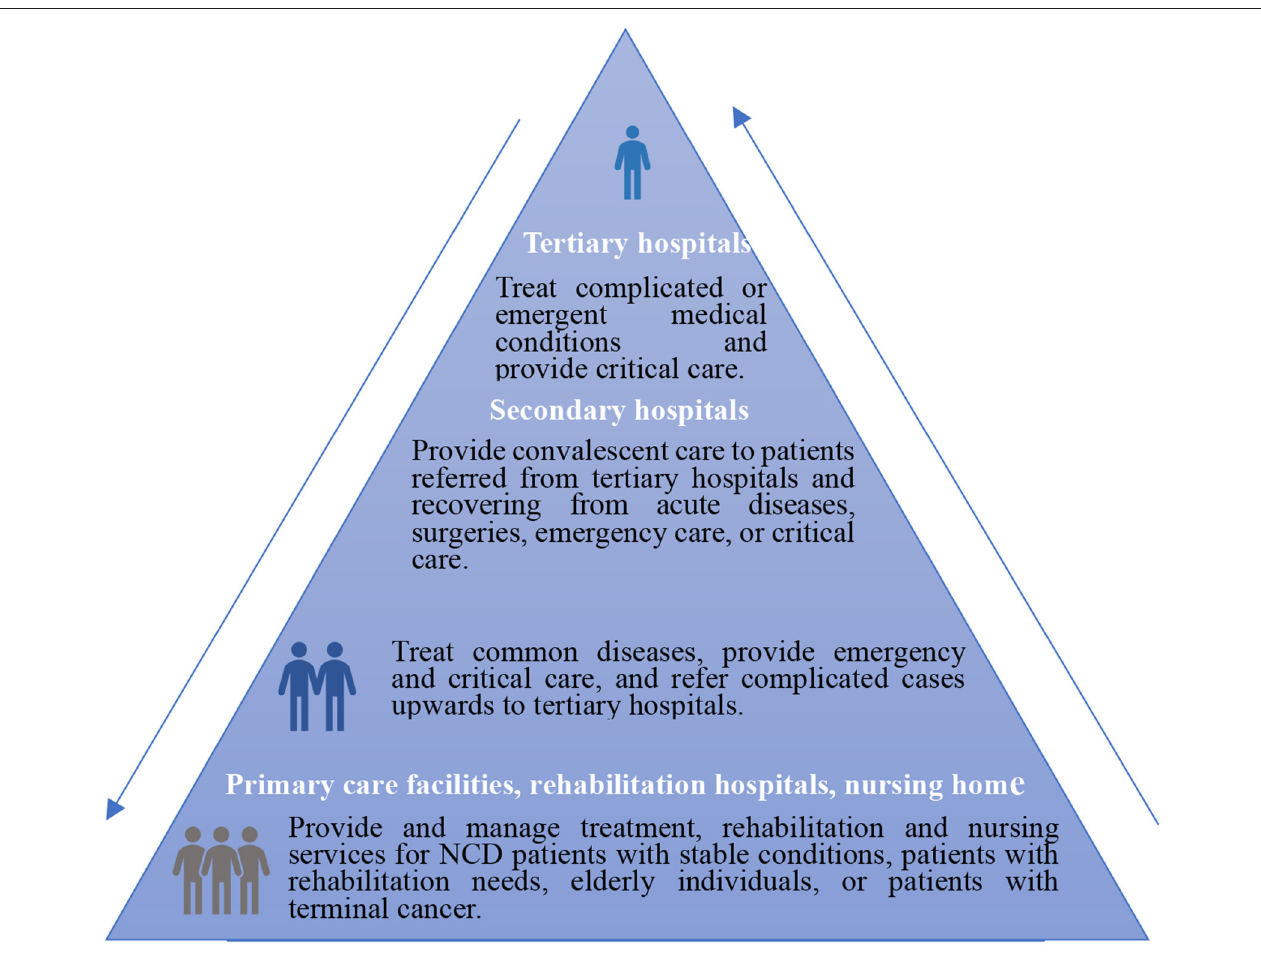
FIGURE 3 | A tiered delivery system. According to the guidance of the general office of the state council on promoting a tiered delivery system. http://www.gov.cn/ zhengce/content/2015-09/11/content_10158.html (accessed September 26,